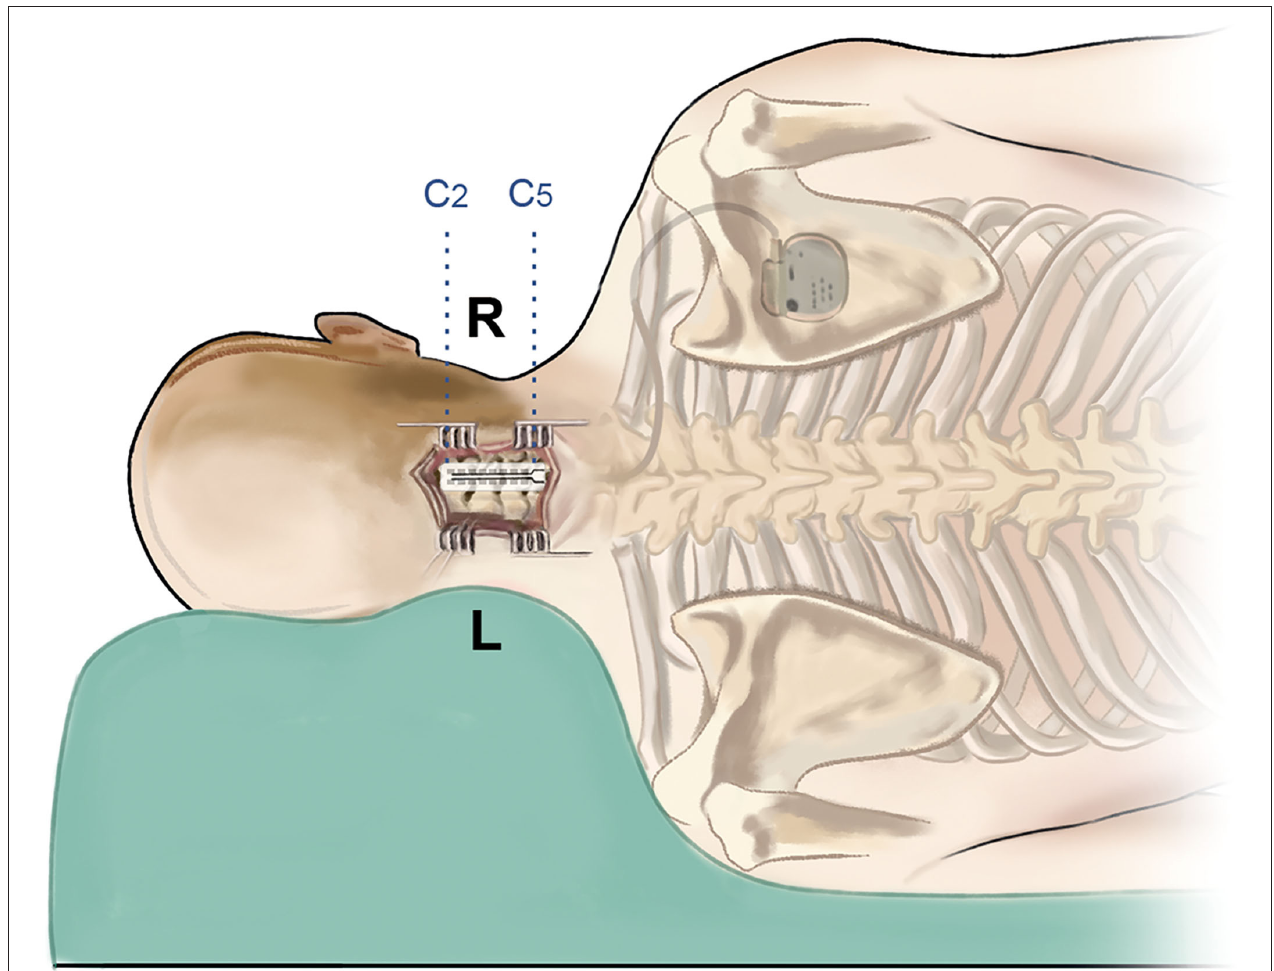
FIGURE 2 | Schematic image of the surgical procedure. The patient is in the left lateral decubitus position, and the incision is at the C2–C5 level. After implantation of the double-paddle electrodes, the stimulator was fixed at the chest wall.